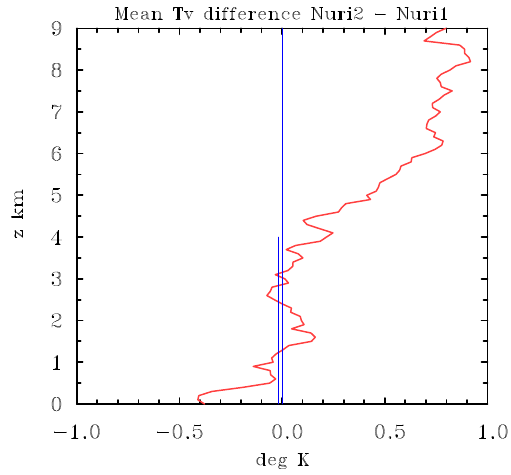
Fig. 6. Vertical profile of the difference in the system-average virtual temperature between Nuri2 and Nuri1: δ ¯ T v = ¯ T v2 − ¯ T v1 , where the overbar denotes the system average. The chosen time interval spans the observed transformation of the pre-Nuri wave-like disturbance into a tropical depression as declared by Joint Typhoon Warning Center forecasters. The thin blue vertical line to the left of the ordinate indicates the related system-averaged temperature difference below 4 km. See text for details.